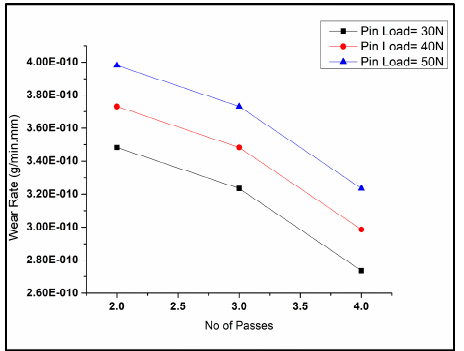
Figure 6. Wear rates of composites with varying number of